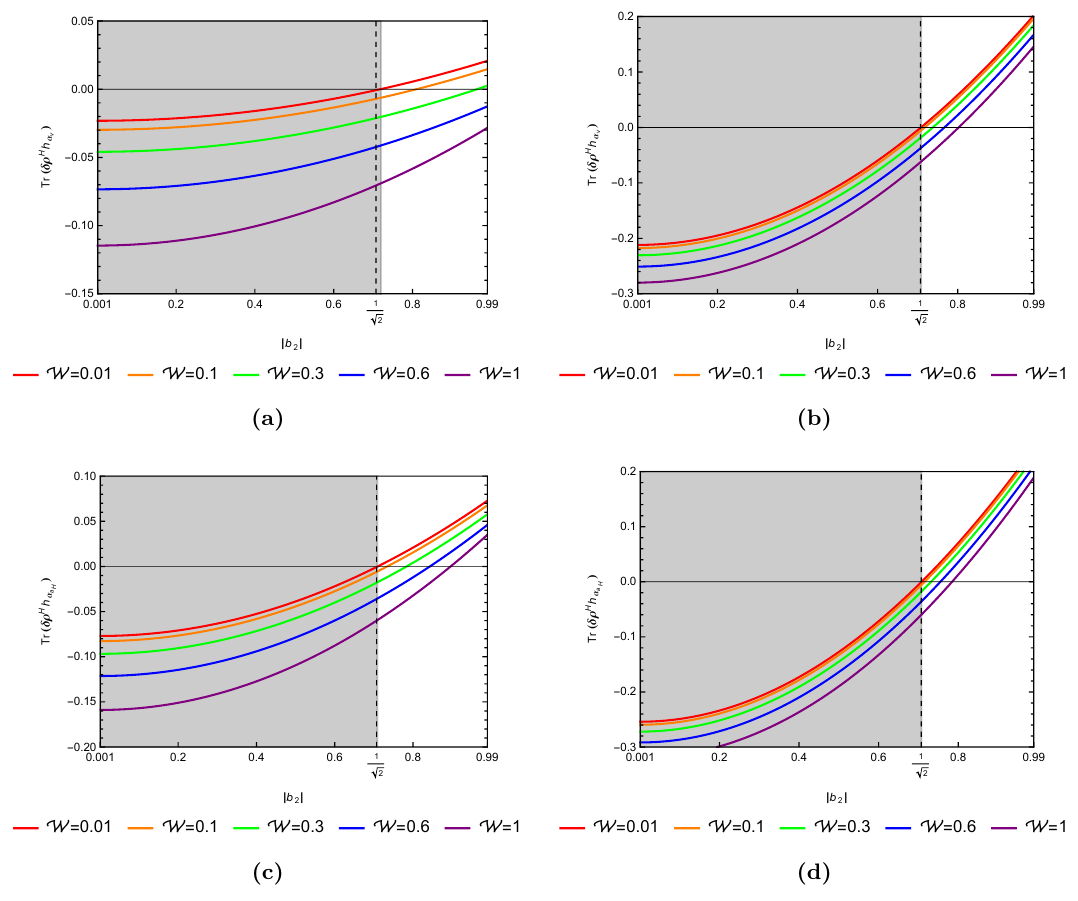
= 0 . 2 Figure 7. Initially non-maximally entangled state for anti-parallel motion (with fixed α a H ): plots (a) and (b) are showing traces corresponding to work done by the system, Tr( δρ H h ) α v with respect to | b for different values of dimensionless energy gap ( W ) of the composite system 2 | for A = 0 . 5 and A = 10 . 0 , respectively. Plots (c) and (d) are showing traces corresponding to heat absorbed by the system, Tr( δρ H h ) with respect to | b for different values of dimensionless α aH 2 | energy gap ( W ) of the composite system for A = 0 . 5 and A = 10 . 0 , respectively. The grey region in the plots roughly represent the regime with negative traces for given W